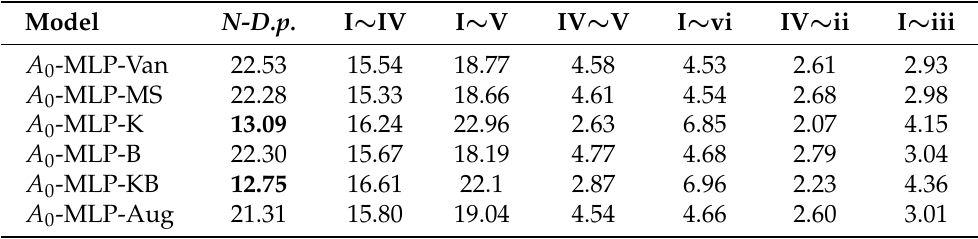
Table 11. Left: percentage of Non-Diatonic prediction ( N-D.p. ) over the classification errors when the target is diatonic, right: errors (>2%) corresponding to degrees substitutions (% of the total number of errors on diatonic targets). In this table, the column I ∼ IV correspond to totals of the errors that satisfy: I substituted to IV or IV substituted to I.